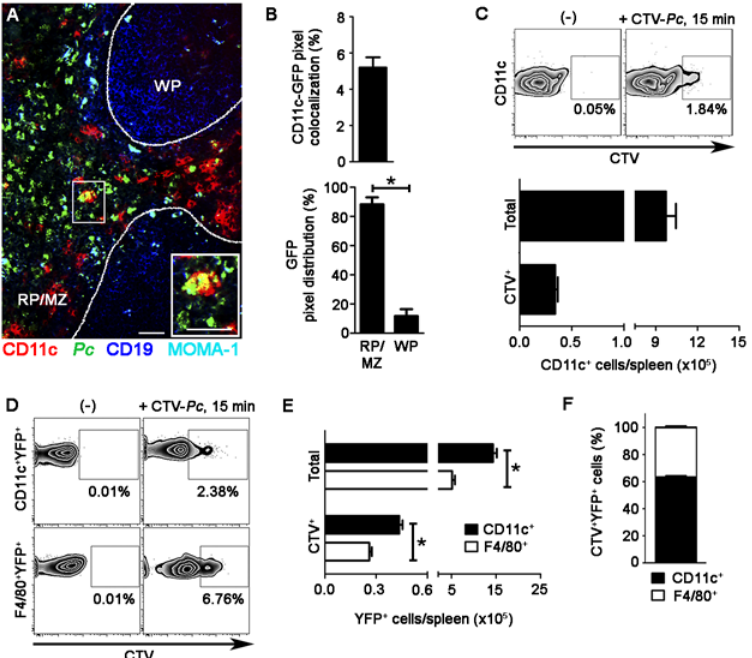
Figure 3. Ex vivo analysis of iRBC uptake by splenic DCs soon after Pc infection. (A-C) B6 mice were i.v. infected with 1 × 10 8 purified mature CTV- Pc iRBCs (flow cytometry) or GFP- Pc iRBCs (immunofluorescence). Spleens were analyzed after 15 min and in non-infected controls. (A) A representative immunofluorescence image (10x magnification) shows the spleen of an infected B6 mouse. The staining of MOMA-1 + metallophilic macrophages and CD19 + B cells delineates the RP/MZ from the white pulp (WP). The lower panel details a merged GFP + CD11c + cell in the RP. (B) Percentage of CD11c pixels colocalized with GFP pixels and percentages of GFP pixel distribution in the splenic RP/MZ and WP were obtained from immunofluorescence images (means ± SD). (C) Representative contour plots obtained by flow cytometry show CTV staining in the CD11c + cells of na ï ve mice (-) and recently infected mice. CD11c + cells in the CD3 - CD19 - DX5 - Ter119 - cell population were analyzed, while excluding T cells, B cells, NK cells and RBCs. Data in contour plots show the percentages of CTV + cells in the CD11c + cell population. The numbers of total and CTV + CD11c + cells per spleen in recently infected mice were calculated from the data obtained in contour plots (means ± SD). (D-F) B6.CD11c-YFP mice were i.v. infected with 1 × 10 8 purified mature CTV- Pc iRBCs. Spleens were analyzed by flow cytometry after 15 min and in non-infected controls. (D) Representative contour plots show CTV staining in the CD11c + YFP + and F4/80 + YFP + cells. Data show the percentages of CTV + cells in each population. (E) The numbers of total and CTV + CD11c + YFP + and F4/80 + YFP + cells per spleen were calculated from the data obtained in D (means ± SD). (F) The relative proportions of CD11c + and F4/80 + cells in the CTV + YFP + cell population were calculated from the data obtained in E (means ± SD). In A , the scale bars correspond to 50 µ m. In B , data were calculated using FIJI software. In B and E , significant differences (p < 0.05) between the indicated groups are designated by * . In A-F , one representative experiment out of three (n = 3-4) is